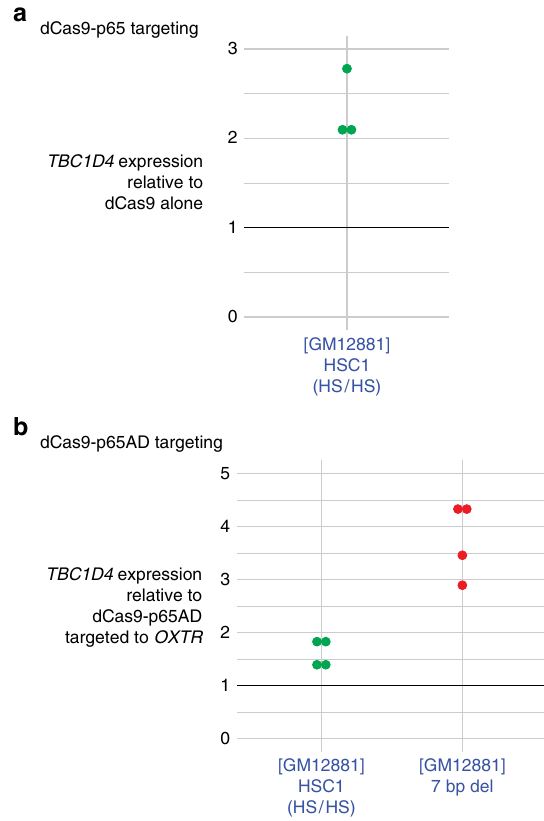
Fig. 10 Targeting of NF κ B to the edited intronic locus helps to restore TBC1D4 expression. In a we show the effect of targeting of the full-length p65 component of NF κ B using CRISPR and catalytically-inactive Cas9 to the edited locus (HSC1 cell line), using a guide RNA targeting the edited NF κ B binding site. This was associated with the increase in expression levels shown (dots show individual replicates, for clarity). Because we